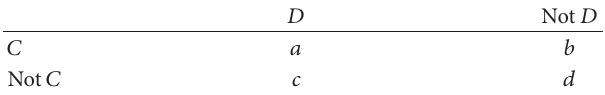
Table 3: Classical GUHA fourfold table.